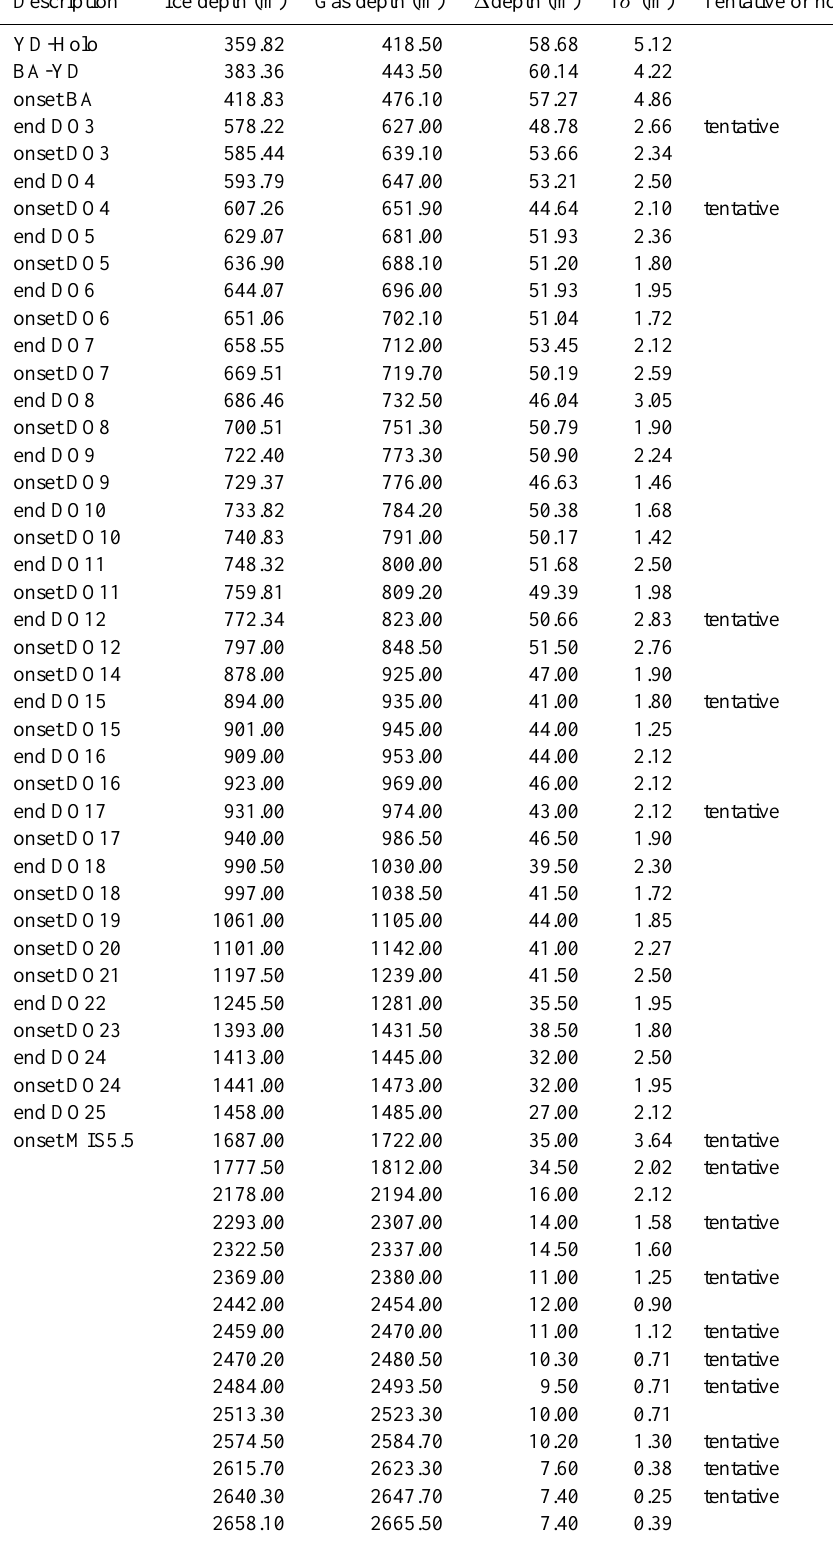
Table 4. Ice-depth/gas-depth synchronisation based on the seesaw method and corresponding 1 depth along the EDC ice